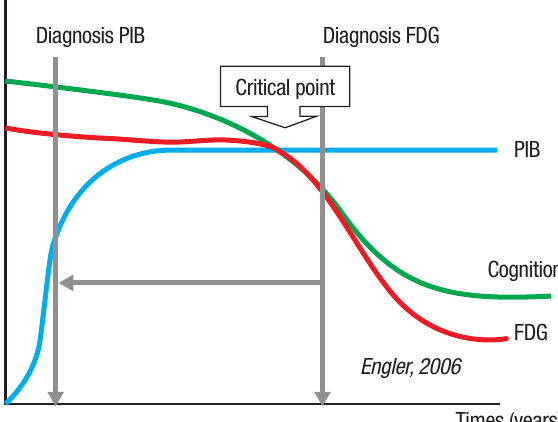
Figure 2. The amyloid deposition seems to begin early in the course of the disease, eventually reaching a “plateau”. Glucose uptake is not af- fected during this